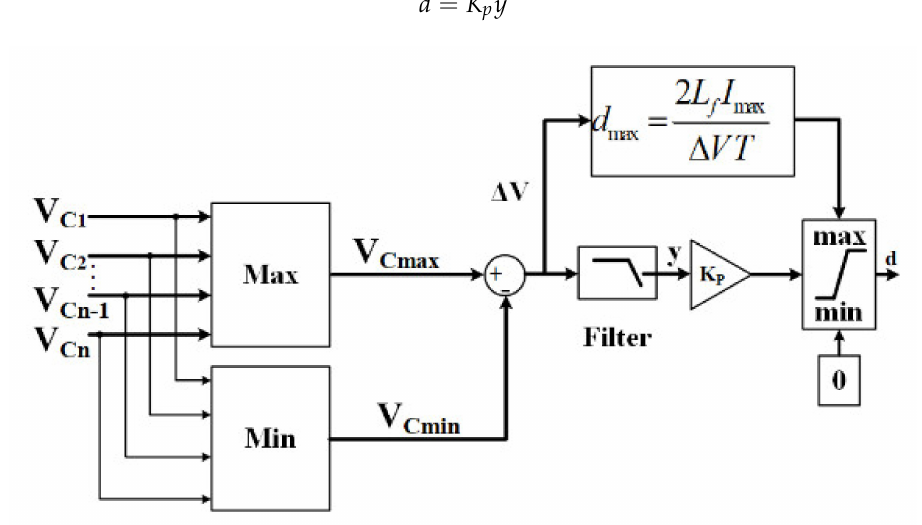
Figure 6. Schematic diagram of the control method used to determine the duty cycle (d) of the H-bridge